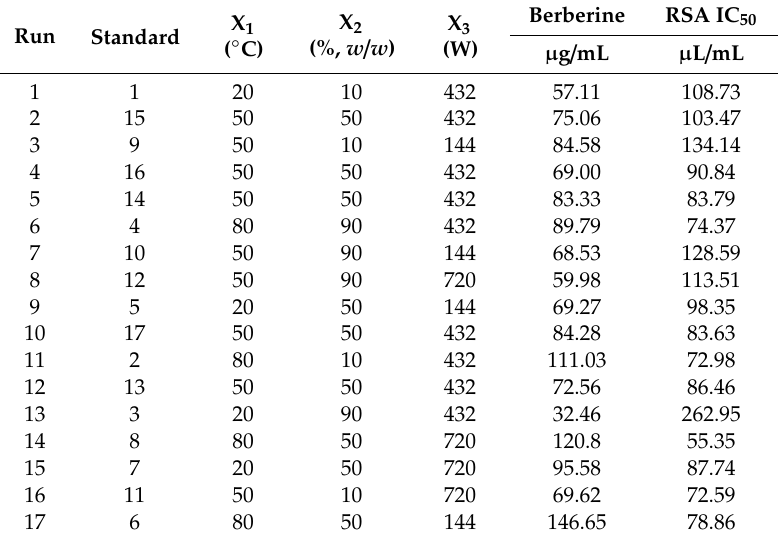
Table 2. The Box–Behnken design and results of experiments.